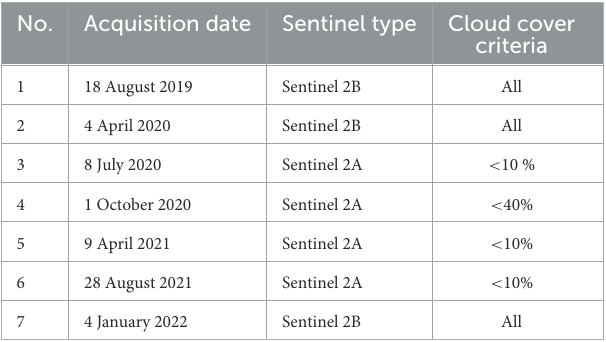
(R) and near-infrared (NIR) (Guo et al., 2021) color bands that are TABLE 1 Satellite imagery data used in the